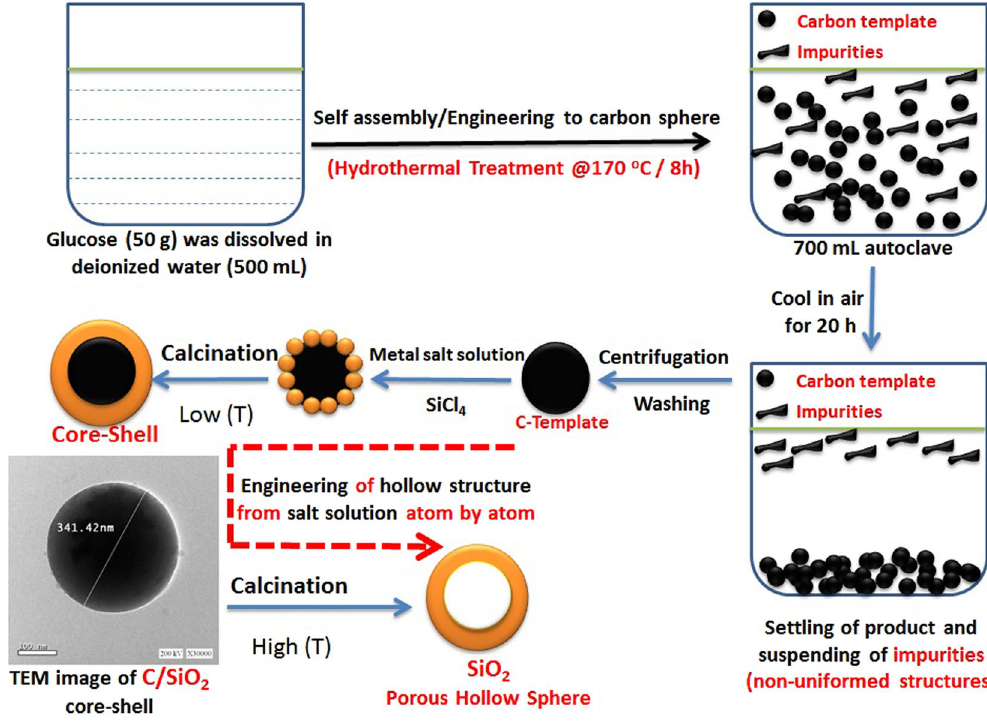
Figure 2. Schematic illustration for the morphology engineering of carbon template from sucrose solution, then using the template to engineer the core-shell and hollow structure from salt solution (bottom-up